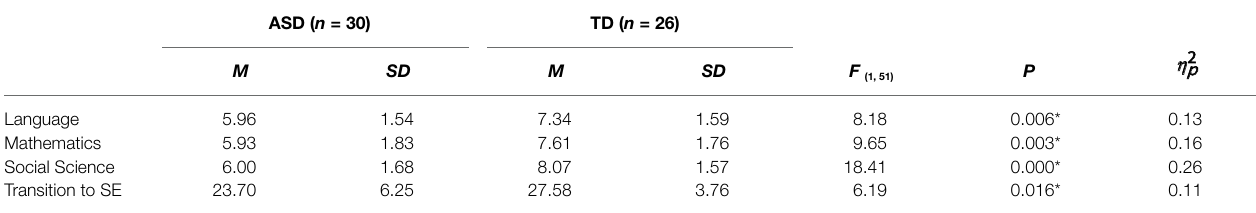
TABLE 3 | Means, standard deviations (SD) of academic results and successful transition to secondary, and statistically significant differences between ASD and TD adolescents. ASD ( n = 30) TD ( n =